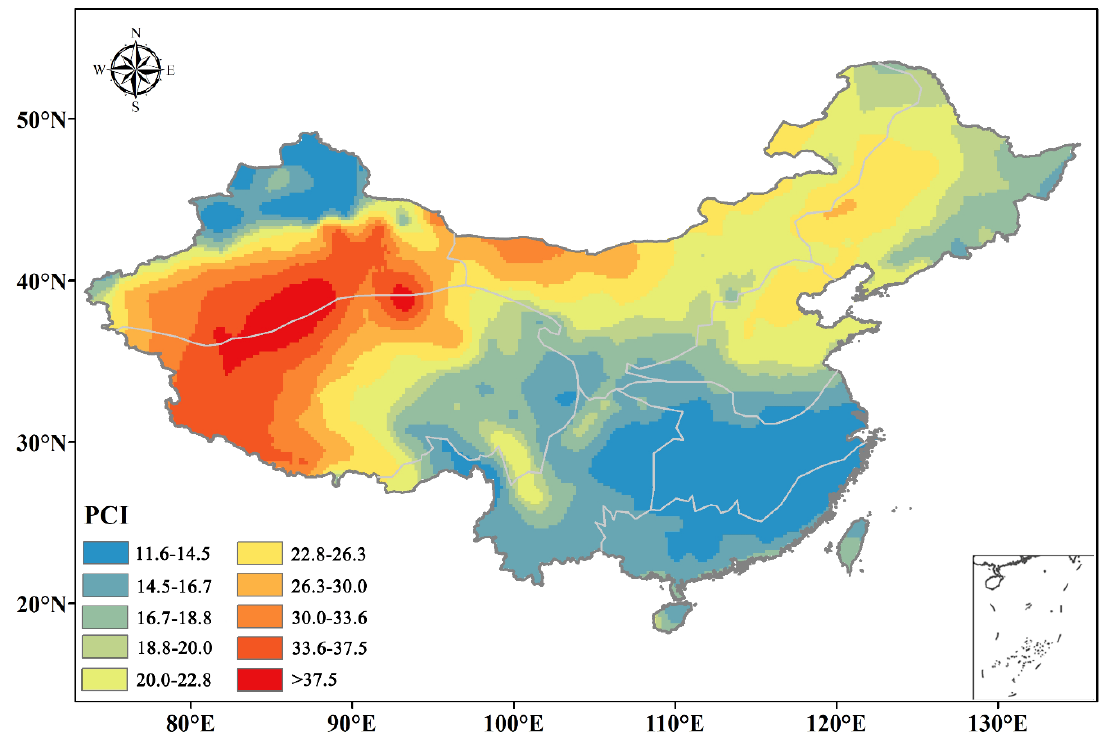
Figure 4. The spatial distribution of the mean annual precipitation concentration index (PCI) across China.